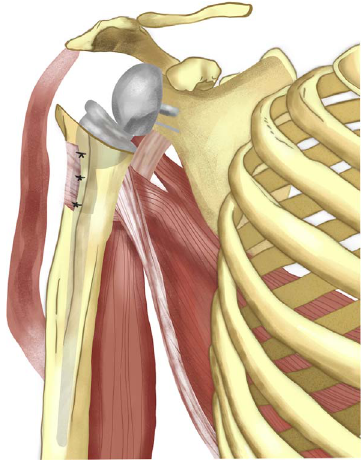
Figure 7. Latissimus dorsi tendon transfer in reverse shoulder